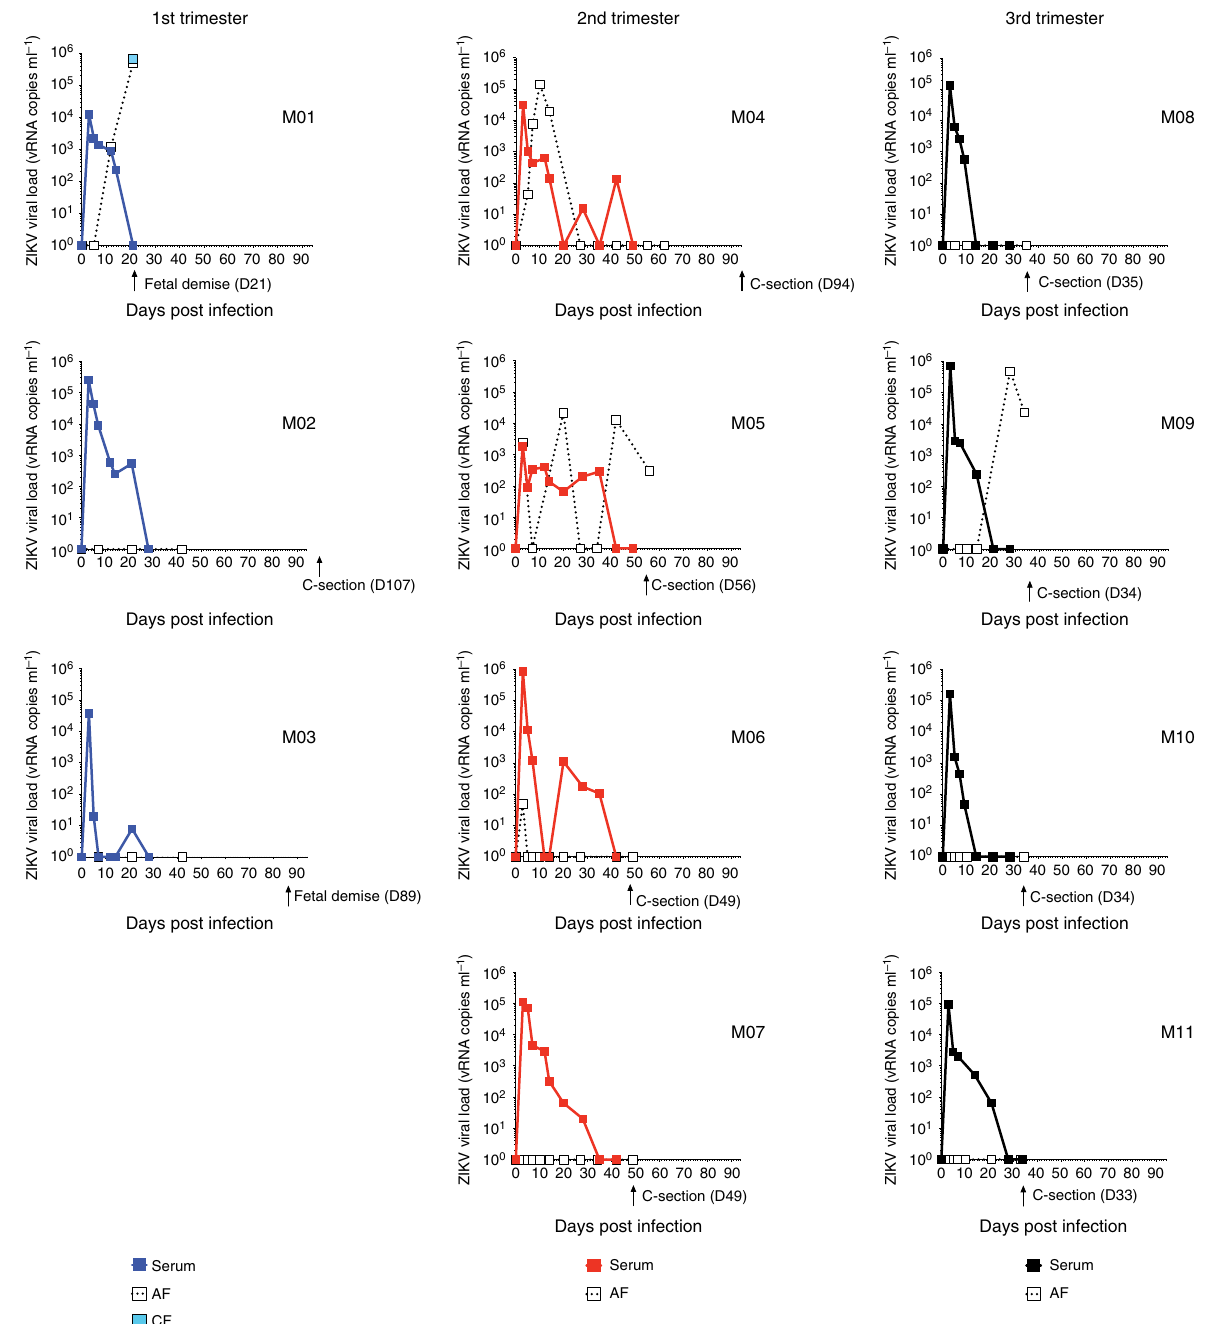
Fig. 2 Pregnant macaques have extended viremia and transmit virus to the fetus. Blood and AF were collected at the indicated time points. At time of C- section or fetal demise, CF was also harvested. Serum ( fi lled square), AF (open square), CF (light blue square) viral loads for 11 macaques in the fi rst (blue), second (red), or third (black) trimester of pregnancy are shown. Date of C-section is indicated by an be born after ZIKV infection (F08, F09, F10, and F11) were equivalent in developmental landmarks to the trimesters of delivered ~7 weeks post challenge of the third trimester animals. human pregnancy 15 . Ultrasound-guided amniocentesis was per- formed, and sera were collected at the indicated time points One of these infants, F11, was not responsive after delivery and (Figs. 1 and 2). was killed. We looked for the presence of viral nucleic acid by qRT-PCR in F11 ’ s necropsied tissues (placenta, umbilical cord, and brain), but could not detect virus. Despite having the most prolonged viremia of the third trimester infected animals, the AF Fetal outcomes of ZIKV-infected pregnant macaques . The was negative for ZIKV RNA at the time of the C-section. The pregnant macaques had viremia beyond day 7 post infection, other infants from dams infected during the third trimester had which contrasts to non-pregnant macaques in prior studies 16 , in no apparent de fi ciencies. which viremia was cleared by day 7 (Fig. 2). The fi rst animals to